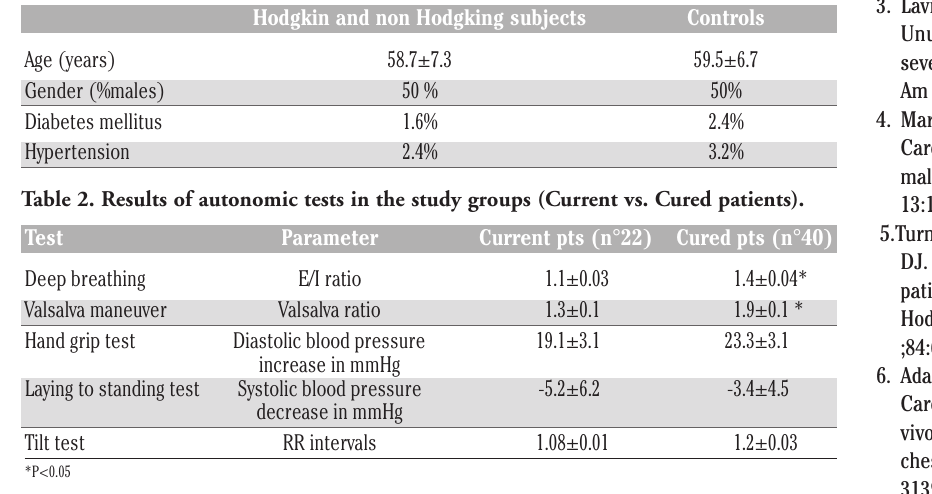
Table 1. General characteristics of Hodgkin and non-Hodgkin subjects and controls.